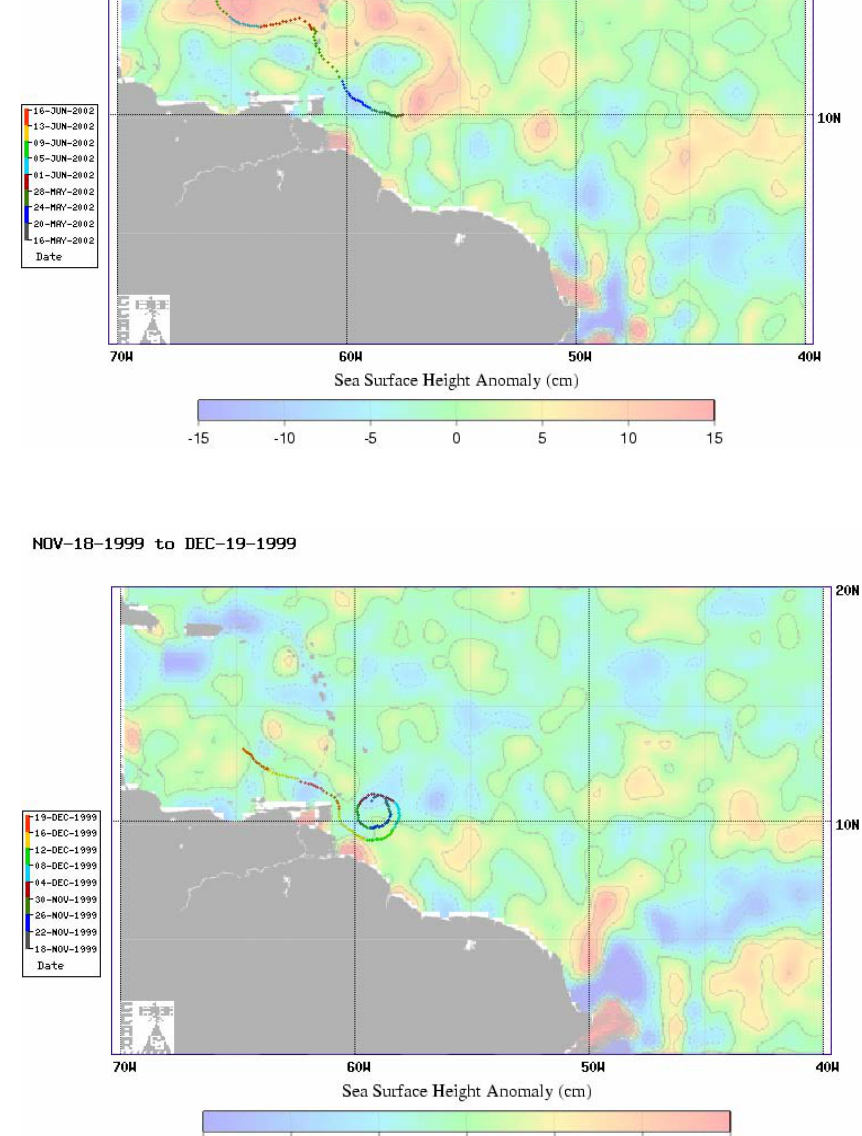
Figure 9. Examples of altimetry SHA data and GDP trajectories showing quasi-coherent near 15–17 ◦ N (top) and non-coherent near 10–12 ◦ N (bottom) propagation of rings through the LA.